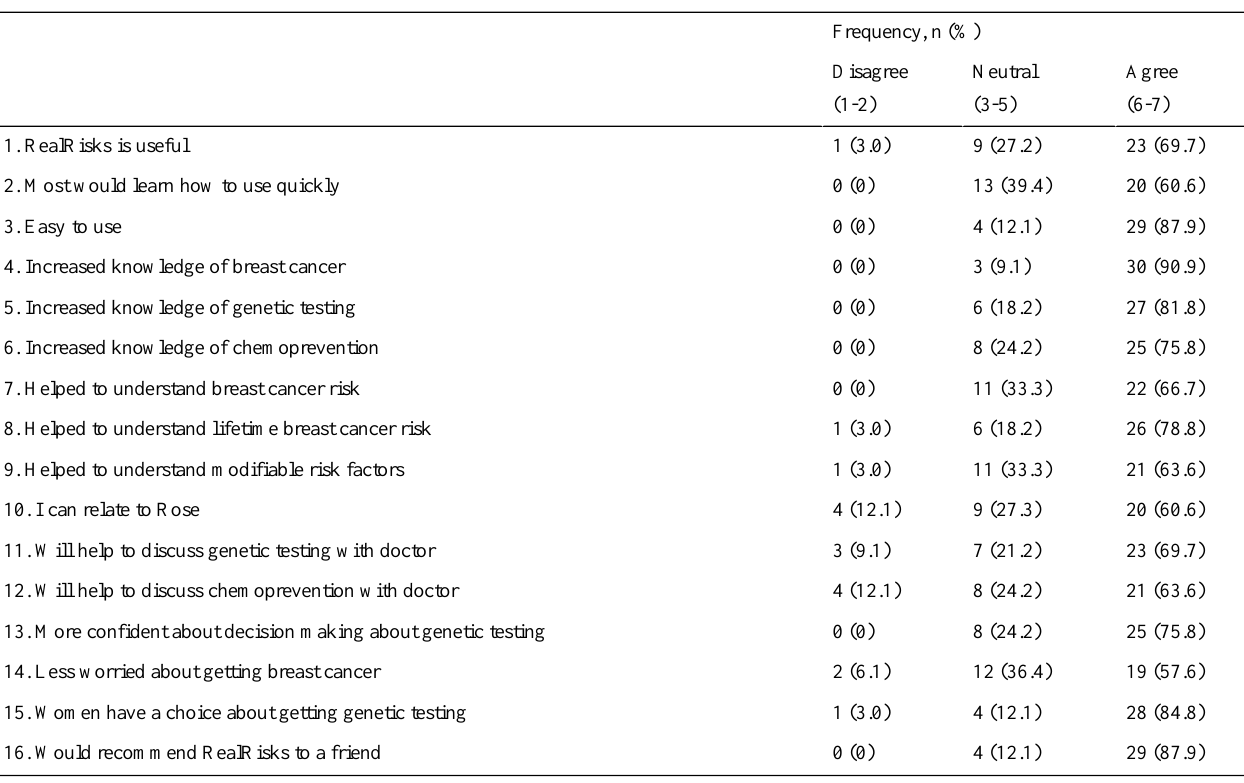
Table 3. Evaluation of the RealRisks decision aid on a 7-point Likert scale among focus group participants, New York City